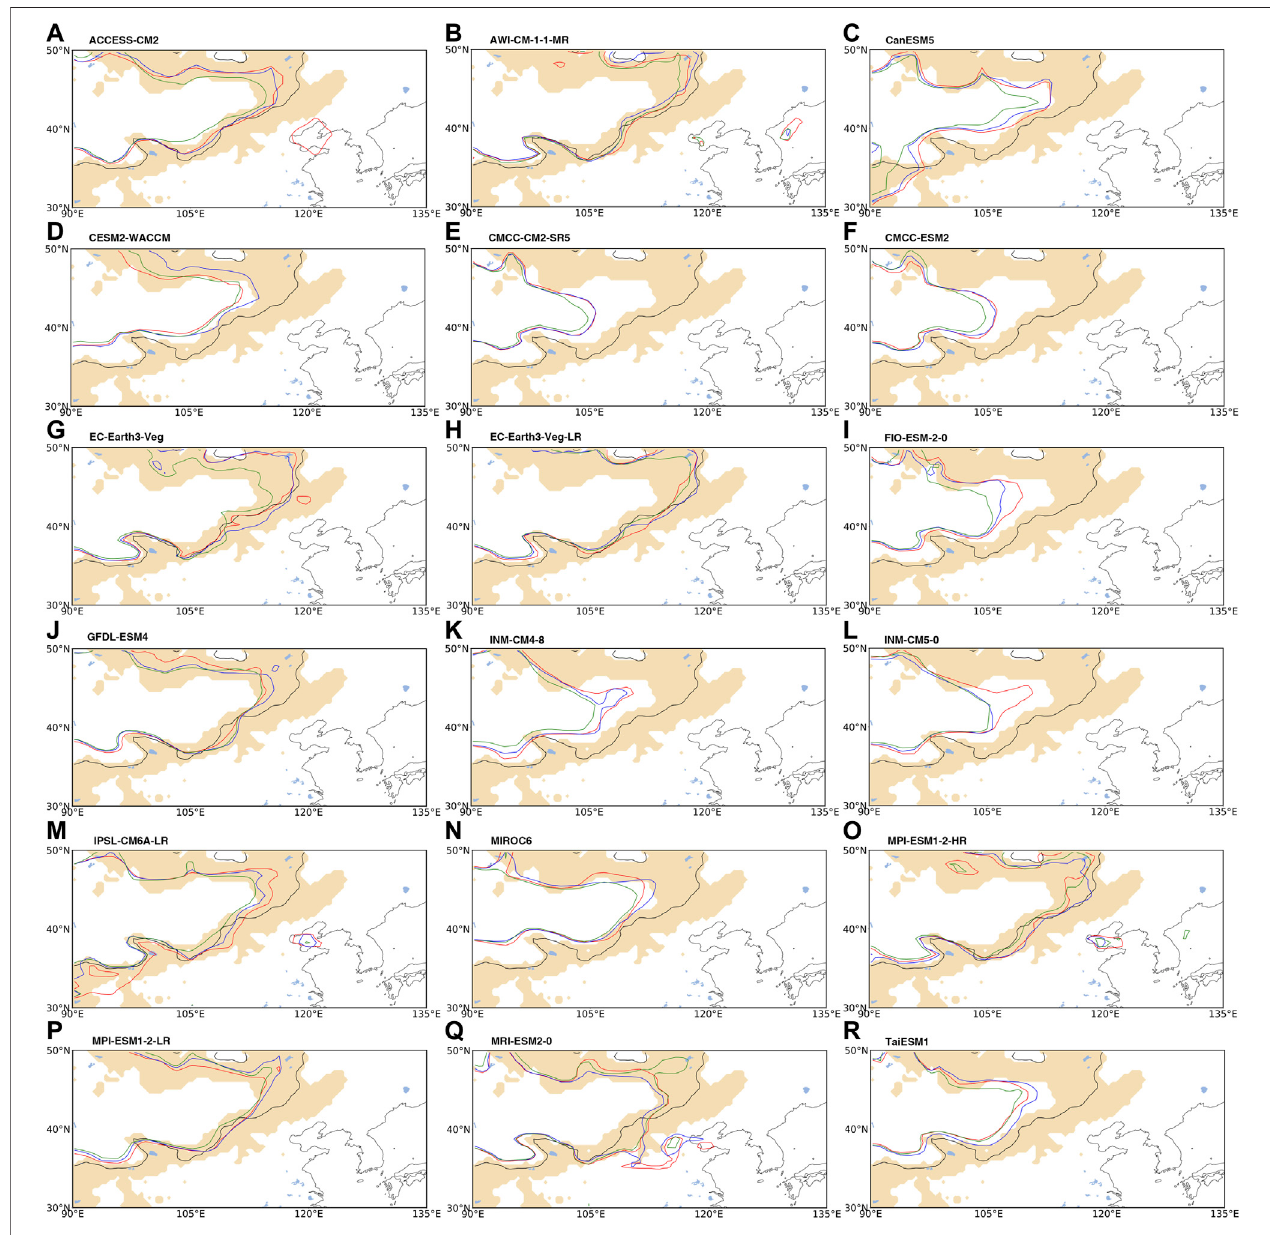
FIGURE 9 | The decadal monsoon edge simulated by the models in the future. The brown areas represent semi-arid areas. The black curve represents the mean monsoon edge for 2011 – 2019. The red, blue, and green curves represent the mean monsoon edges for 2091 – 2100 under SSP126, SSP245, and SSP585,